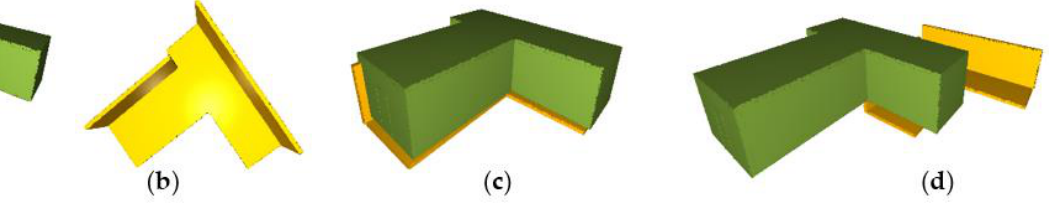
Figure 16. Visualization of ( a ) complete as-planned model, ( b ) incomplete as-built model with only three plane segments in distinct directions, ( c ) registered model using translation computed from the centroid of matched segments, and ( d ) registered model using translation computed from the centroid difference of the complete point cloud .